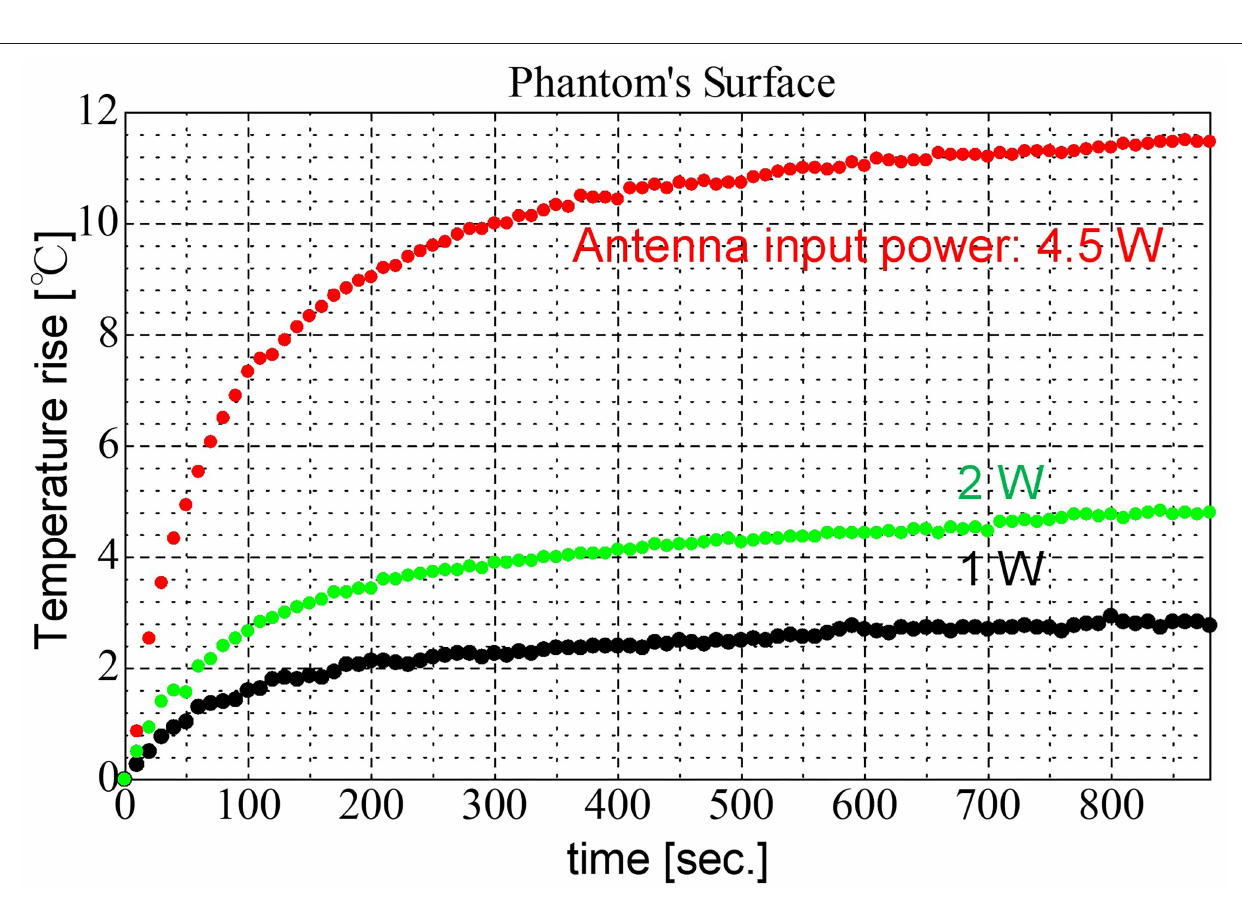
Frontiers in Public Health |